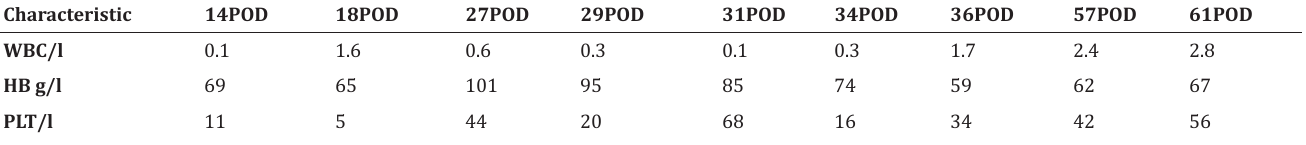
Changes in peripheral blood parameters by day from the moment of autologous bone marrow transplantation. Against the background of the complex therapy of hemoblastosis and COVID-19, an increase in the level of leukocytes is observed and bone marrow engraftment is noted.